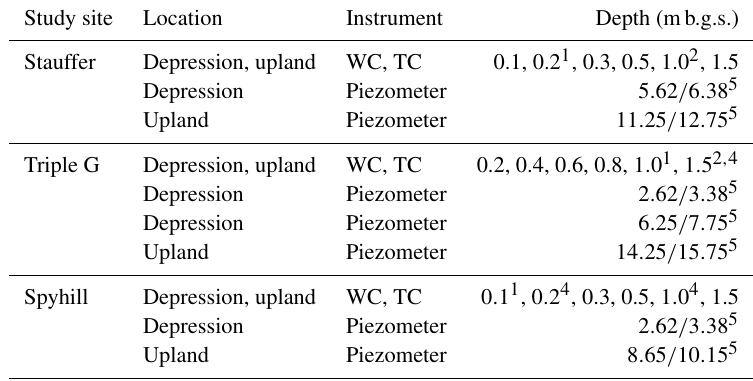
Table 1. Subsurface instrument depths and piezometer screen intervals.